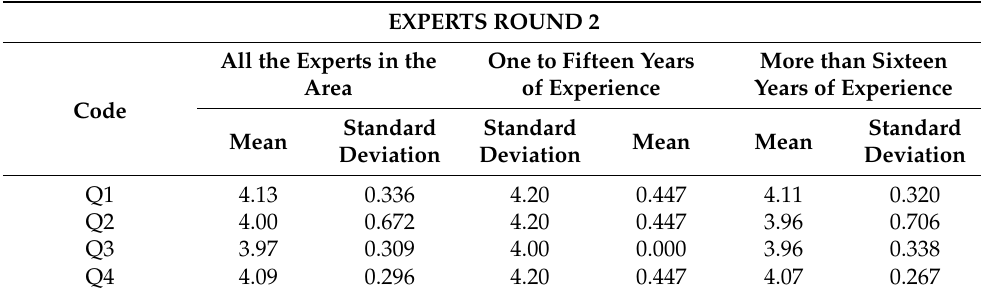
Table 5. Second round of Delphi survey-BIM integration in steel construction